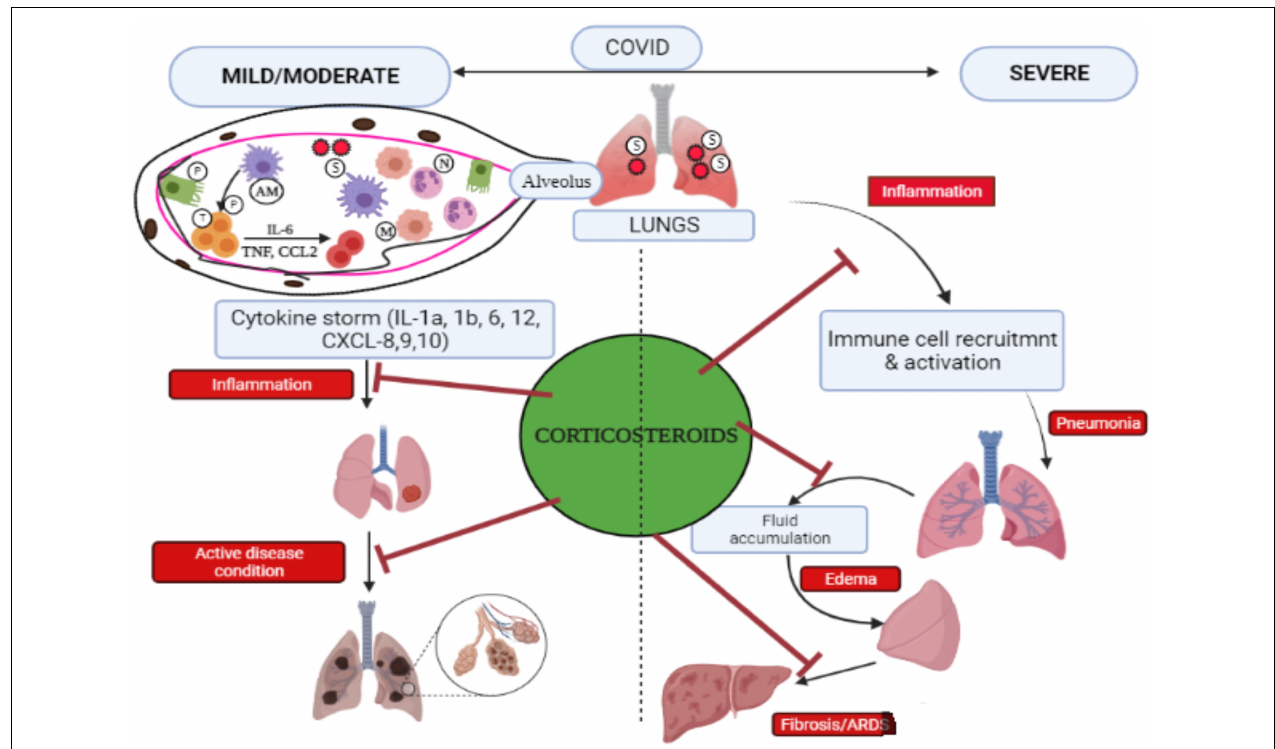
FIGURE 3 | Pictorial representation of pathological events that occurred during COVID-19 and the efficacy of corticosteroid to control COVID-19 infection. SARS-CoV-2 gets inside the host via the pulmonary route, penetrates the alveoli, and interacts with alveolar macrophages (AMs) and pneumocytes (P). Infectious AMs release cytokines/chemokines that recruit and trigger other immune cells such as T cells (T) to produce cytokines, causing “cytokine storm,” and monocytes (M) along with neutrophils (N) move from the blood to the infection site. The lungs in COVID-19 cases in severe condition at late stage lead to acute respiratory distress syndrome (ARDS) and pulmonary fibrosis. Corticosteroids help in inhibiting inflammation caused by cytokine storms and prevent several problems associated with severe COVID-19 including pneumonia, edema, ARDS, and fibrosis. Adapted and modified from Gopalaswamy and Subbian (2021) with